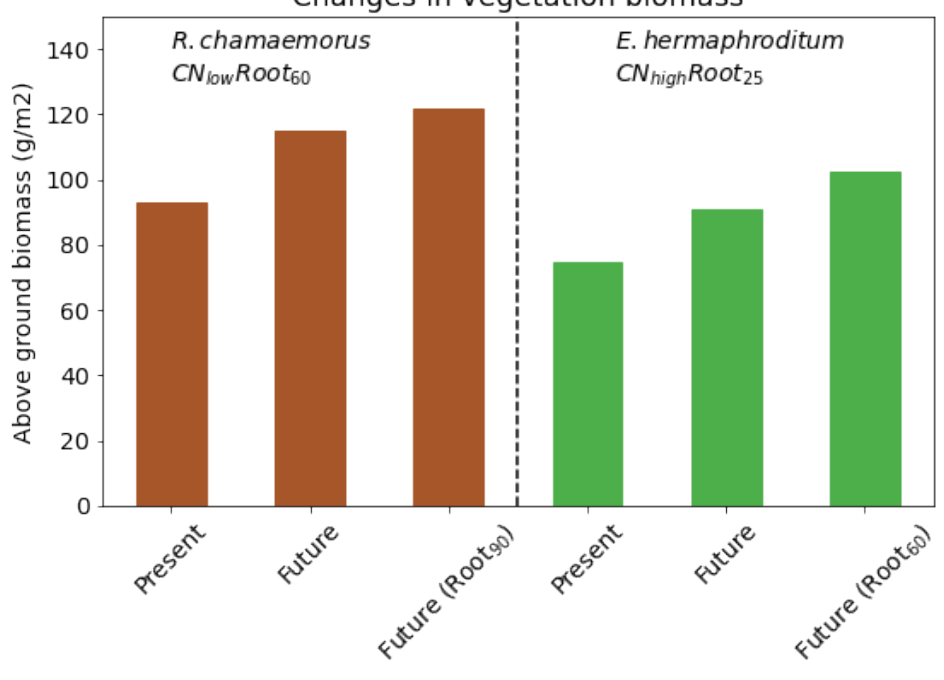
Figure 9. Vegetation aboveground biomass for CN low Root 60 and CN high Root 25 and CN low Root 60 for the present (2001–2010) and future (2090–2099). Also shown are the two future scenarios where the roots have responded to the increase in thaw depth CN low Root 90 (labelled Future-Root 90 ) and CN high Root 60 (labelled Future-Root 90